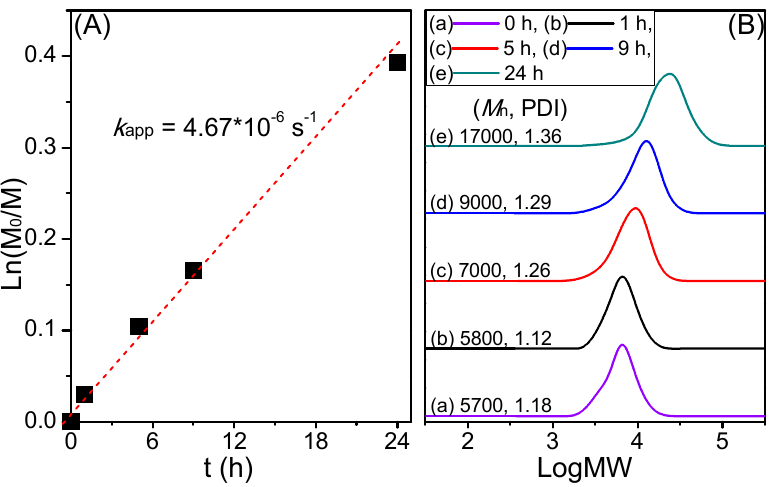
Figure 4. Chain extension of PCL-VBC 4 -PCL with St of ( A ) kinetic plots and ( B ) GPC traces (eluent: THF).